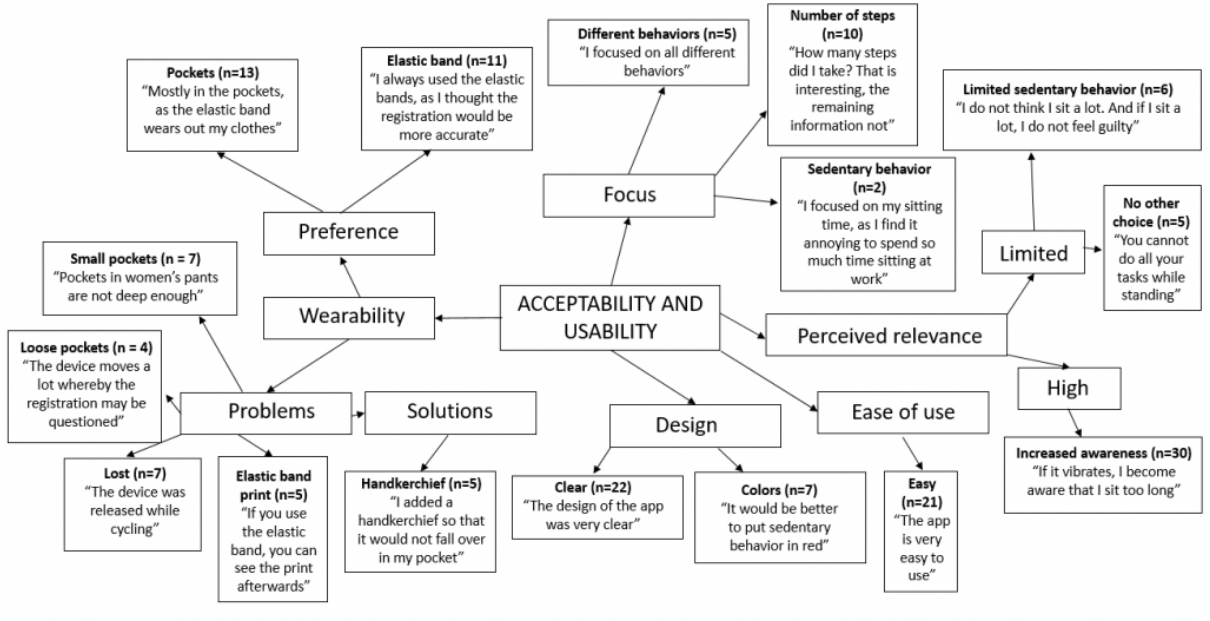
Figure 5. Pen profile on acceptability and usability of the intervention.